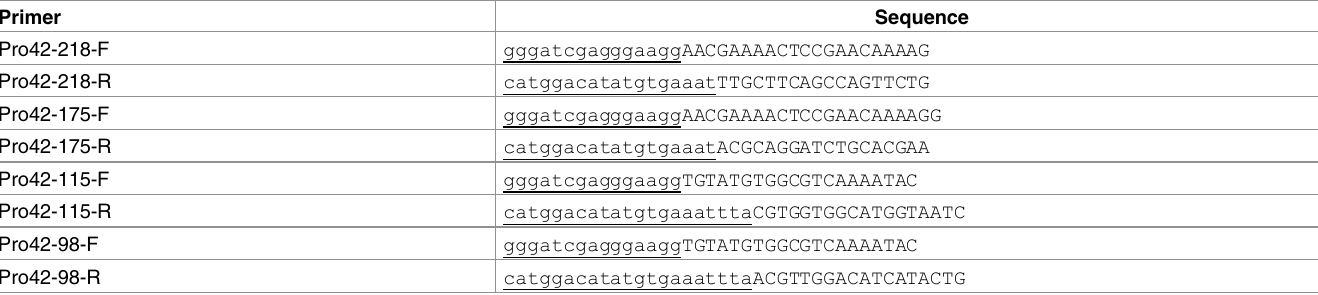
Table 1. Primer sequences used in Gibson assembly